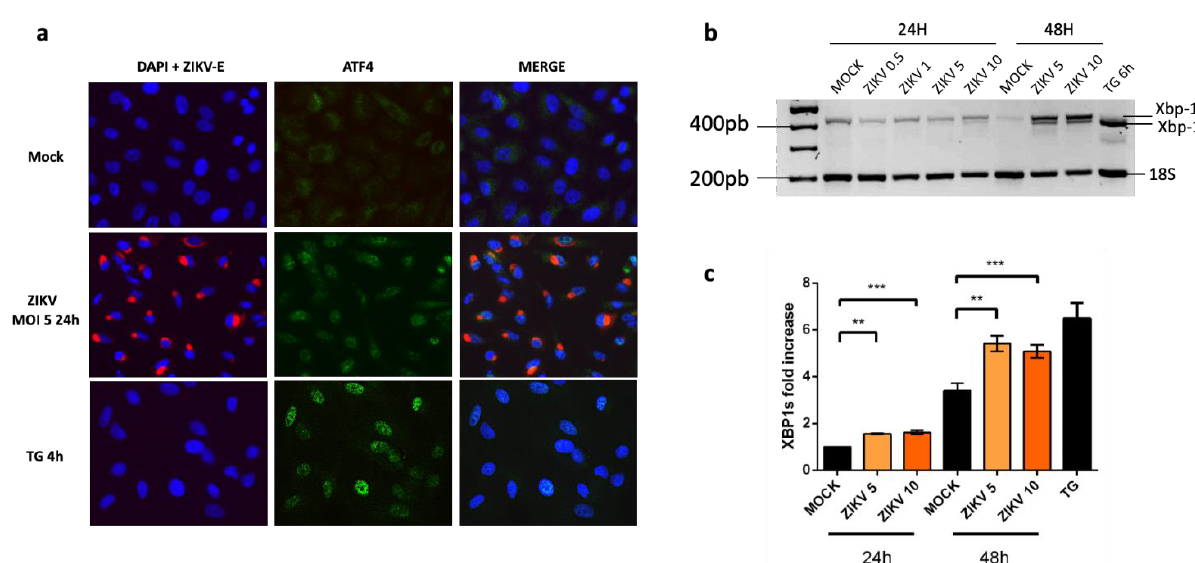
Figure 2. UPR inducible Transcription Factors, ATF4 and Xbp-1(s) are up-regulated in A549 cells infected with ZIKV. ( a ) Cells were infected with ZIKV at MOI = 5 for 24 h or treated with TG for 4 h. Cells were immunostained for ZIKV enve- lope (ZIKV-E, red) and ATF4 protein (green). Nuclei were stained with DAPI (blue). ( b ) RT-PCR of total Xbp-1 (spliced and unspliced) was performed in A549 cells infected with ZIKV at MOI 1, 5 or 10 for 24 h and 5 and 10 for 48 h post in- fection. Products were migrated on 2.0% agarose gel and compared to the one obtained in mock-infected cells and in cells treated with TG, the ER stress/UPR pharmacological inducer. ( c ) qRT-PCR analysis of Xbp-1(s) mRNA was performed in A549 cells infected or not with ZIKV at MOI 10 for different times as indicated. Our positive control cells have been treated with TG for 6 h. Data were presented as mean SEM ( n = 3). *** p < 0.001, ** p < 0.01, vs. mock.